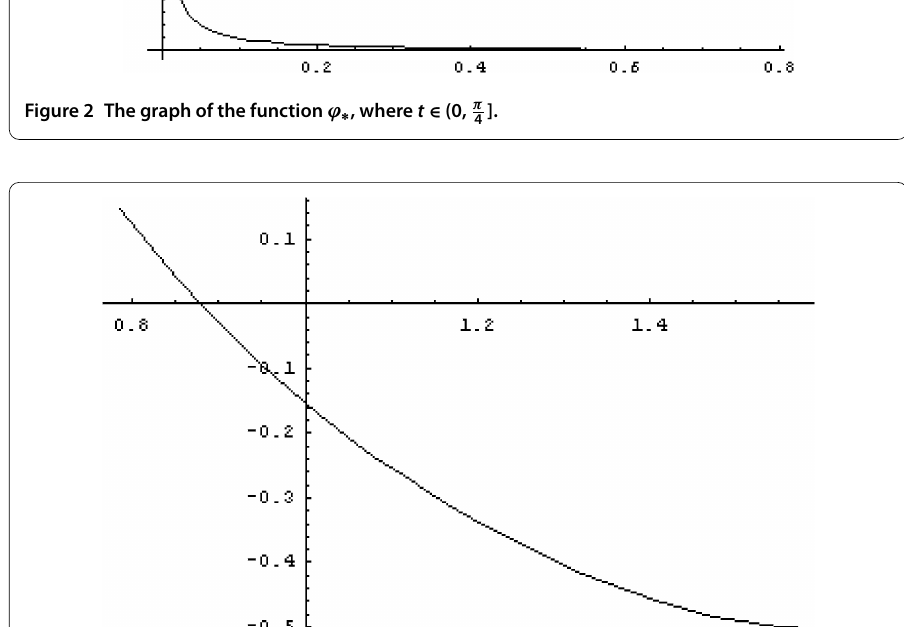
Figure 3 The graph of the function ϕ ∗ , where t ∈ [ π